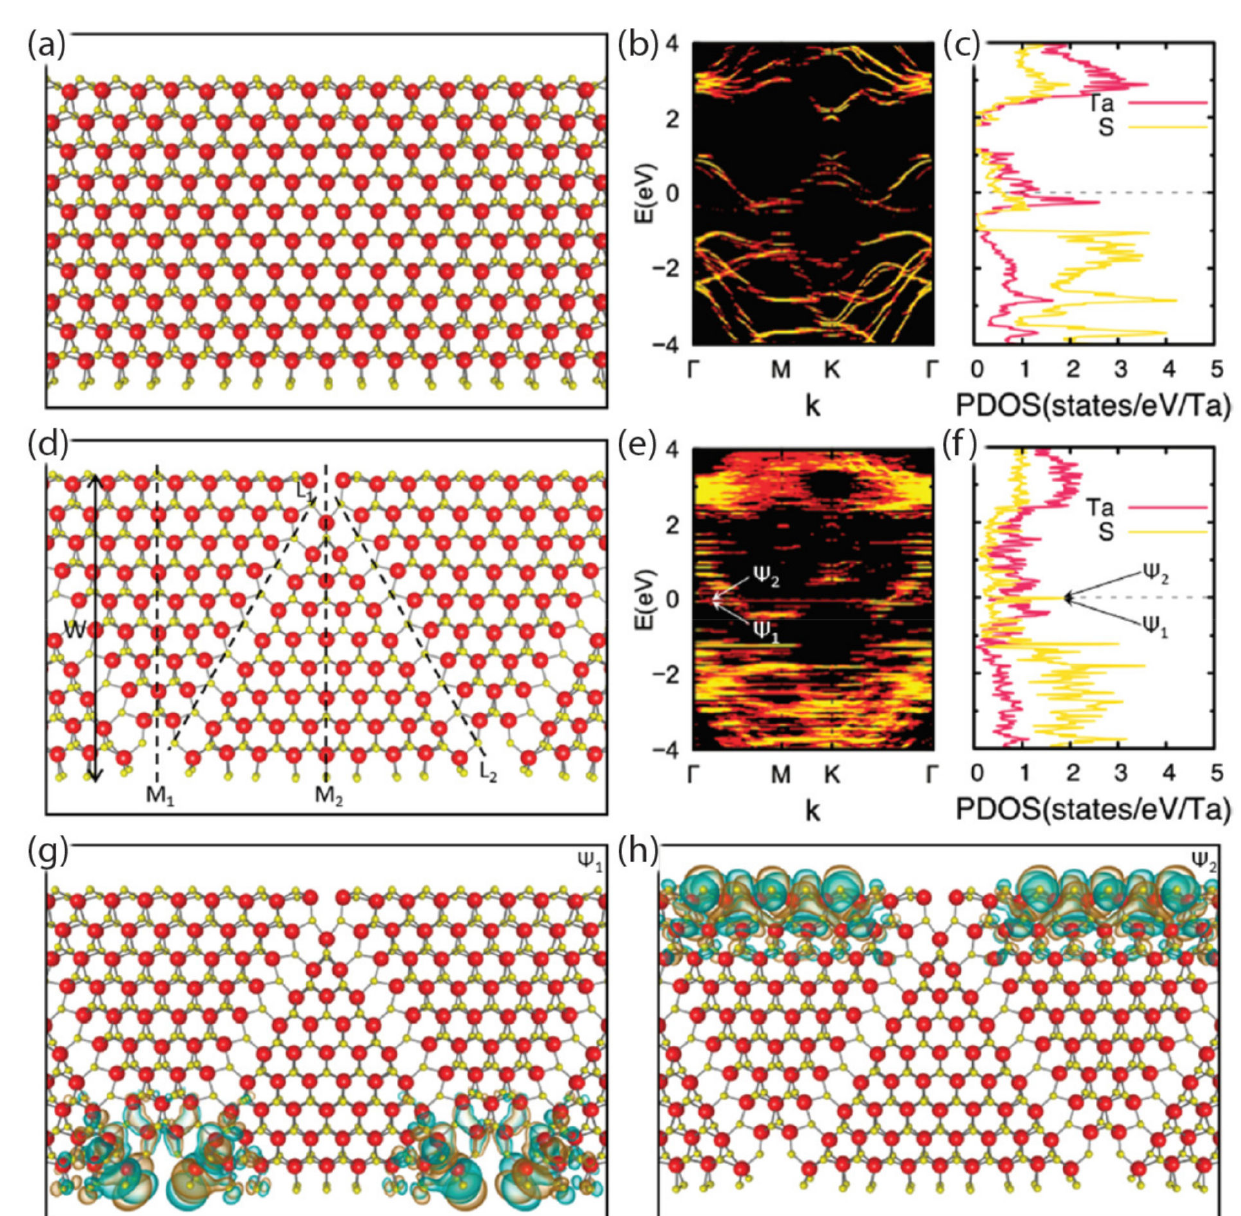
Figure 8. Atomic and electronic structure of TaS 2 nanoribbons as shown by Cain et al. [119]. ( a ) The planar atomic structure of a 2.99 nm–wide nanoribbon is shown without the zigzag defect, whose CDW distortions are too small to be seen. ( b ) The electronic band structure is shown. ( c ) The partial density of states (PDOS, DOS) of the nanoribbon is plotted. ( d ) A planar view of the atomic structure of a 3.08 nm–wide nanoribbon is shown, with zigzag boundaries of S vacancies represented by black dashed lines denoted as L1 and L2. ( e ) The electronic band structure and ( f ) the PDOS of the nanoribbon are calculated. Localized edge states are denoted as ψ 1 and ψ 2 . Structures in ( g , h ) show real-space wave functions of those localized edges states, with isosurfaces for the positive and negative wave function values shaded in cyan and orange, respectively. Ta and S atoms are represented by red and yellow spheres, respectively. Reprinted with permission from Reference [119]. Copyright 2021 by the American Chemical